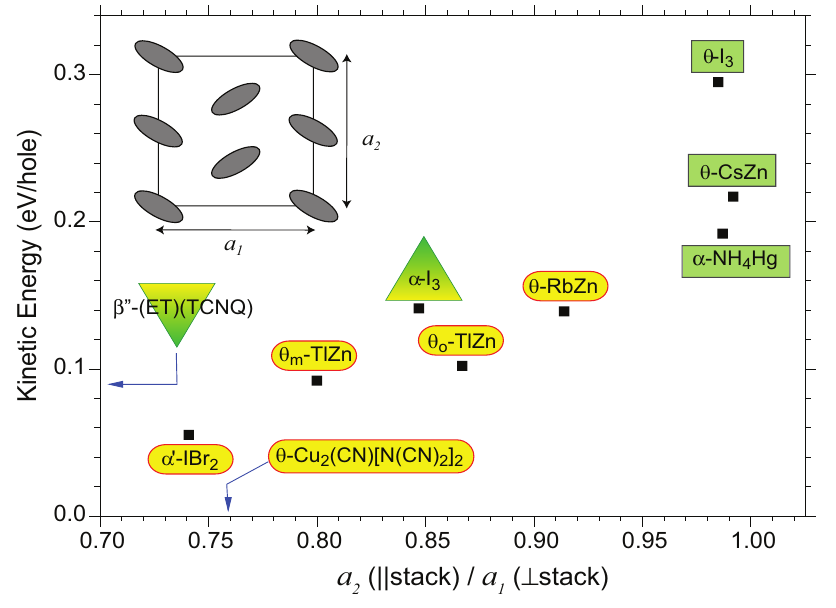
Figure 27. Kinetic energy per a formula unit ( ■ ) plotted as a function of the lattice parameter ratio. In the case of the θ -type crystal, the crystal axis along the stacking direction is doubled. The inset shows the schematic molecular arrangement and crystal axes. In the compounds framed by the green rectangle, the CO amplitude is small ( Δρ ~0.1) over the whole temperature range. In the compounds framed by the yellow rounded rectangle, the CO amplitude is large ( Δρ ~0.6) over the whole temperature range. In the compound framed by the triangle, the CO amplitude changes at the phase transition, small amplitude ( Δρ ~0.2) at high temperature and large amplitude ( Δρ temperature. In the compound framed by the inverted triangle, the amplitude changes continuously, large amplitude at high temperature ( Δρ ~0.6) and small amplitude ( Δρ ~0) at low